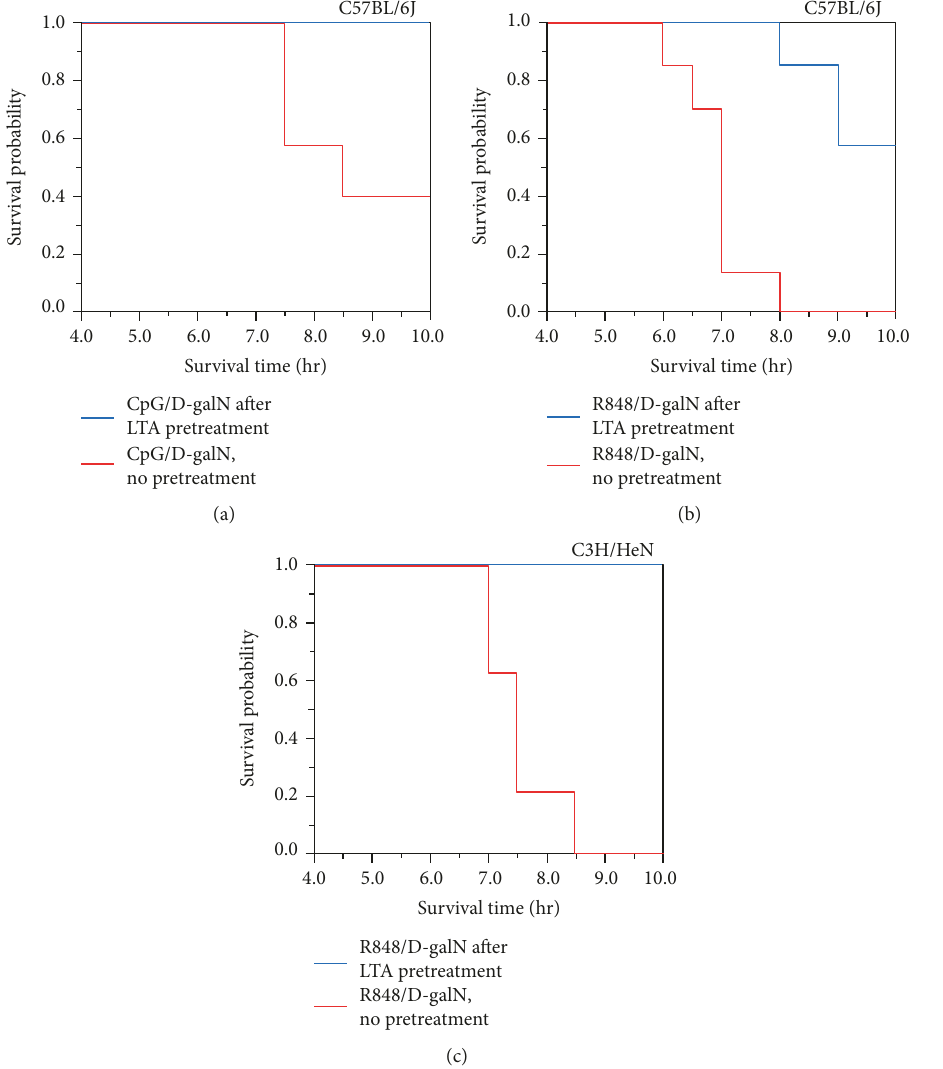
Figure 2: Survival rate analysis of the tolerance-inducing e ff ect of LTA pretreatment based on the Kaplan-Meier method. (a) C57BL/6J mice treated with CpG/D-galN. (b) C57BL/6J mice treated with R848/D-galN. (c) C3H mice treated with